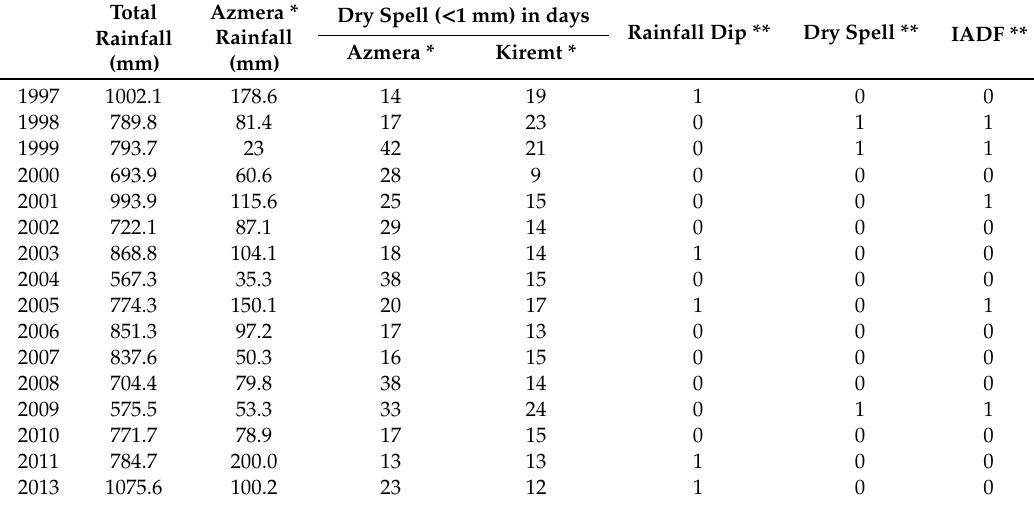
Figure 6. Dispersion graph of tree-ring formation in Erica arborea showing the vessel lumen area in relation to the distance from the beginning of the tree ring. The dispersion graph indicates the polynomial interpolation line for tree rings with IADFs in black, and the polynomial interpolation line for tree rings without IADFs in gray. The arrow points to the end of the IADF. Table 1. Rainfall indices and IADF formation.